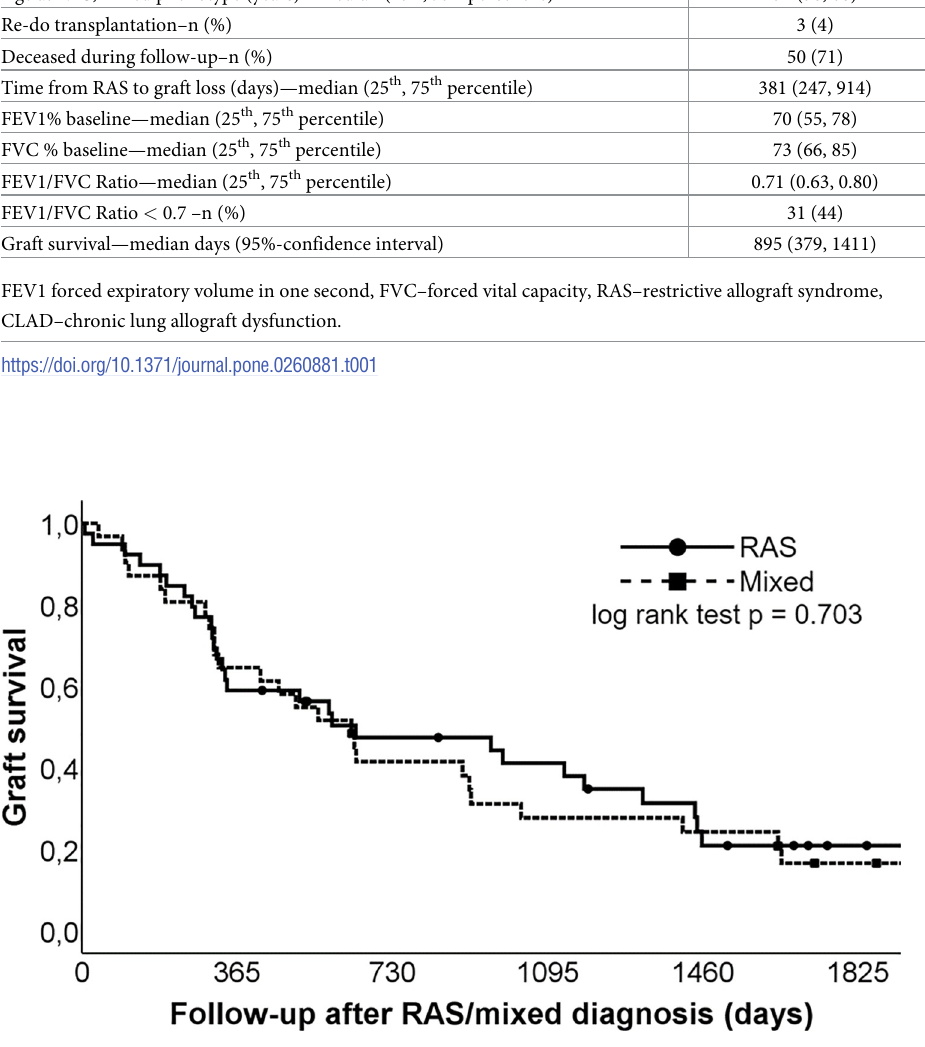
Fig 1. Kaplan-Meier curve of graft loss. RAS- restrictive allograft